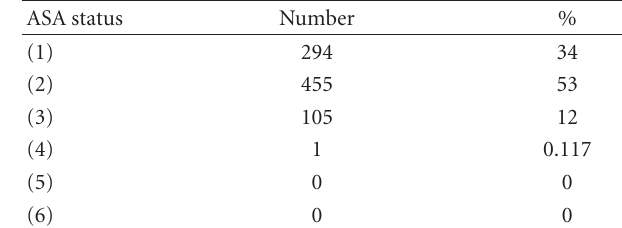
Table 2: ASA physical status.